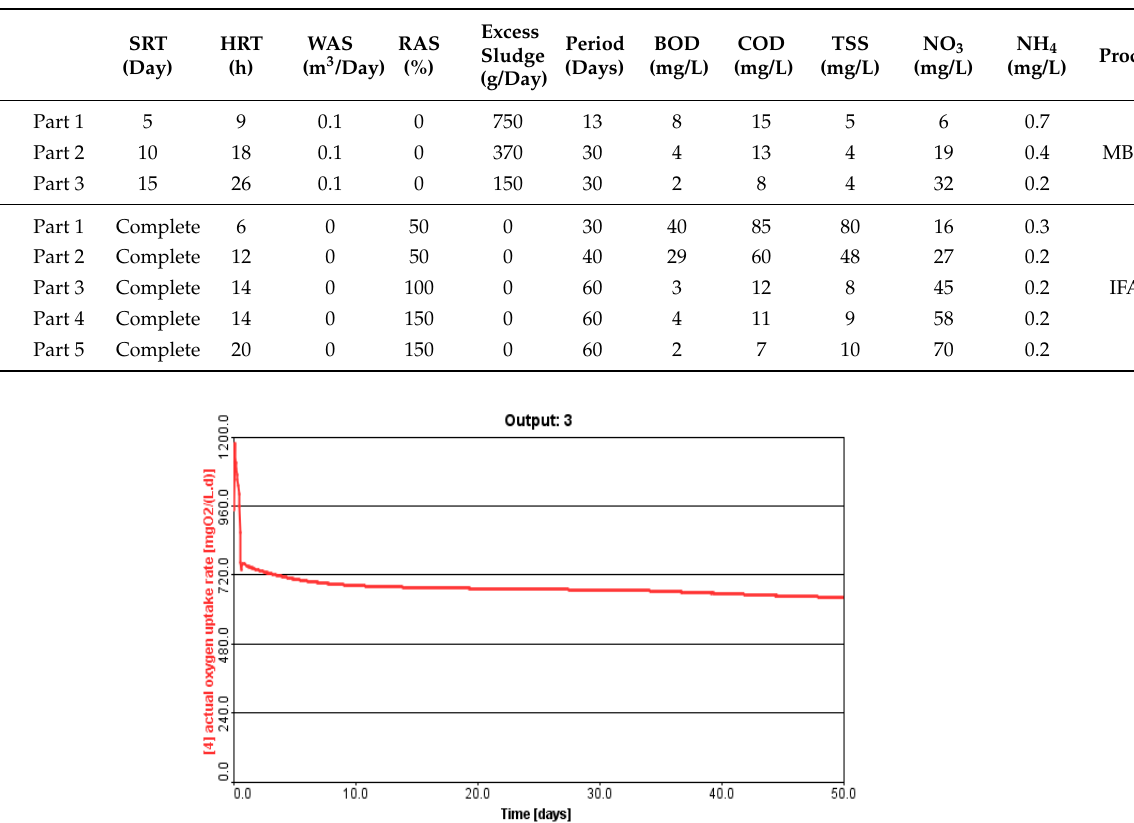
Table 3. Sludge production and effluent pollutants concentrations at different operational conditions of MBBR and IFAS processes.